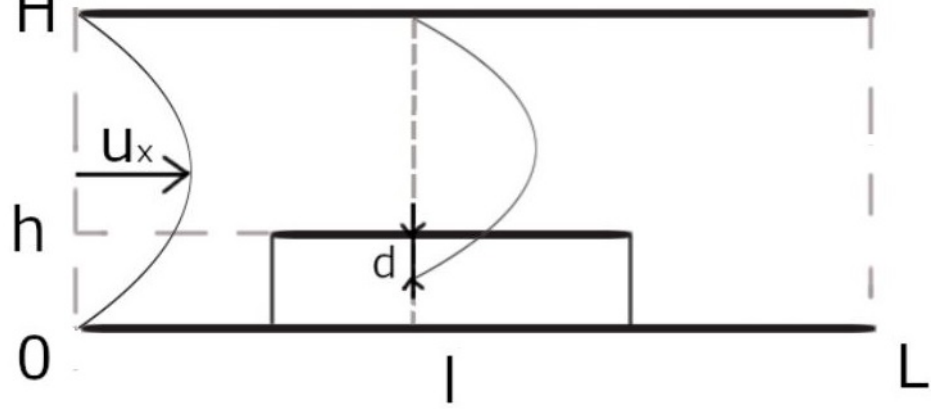
Figure 3. Schematic representation of blood vessel (length L , height H ), rectangular clot (length l , height h ), and parabolic flow velocity at the vessel inlet and above the clot. Note that the flow velocity above the clot does not vanish at the clot surface but below it at y = d − h since the clot is partially penetrable for fluid